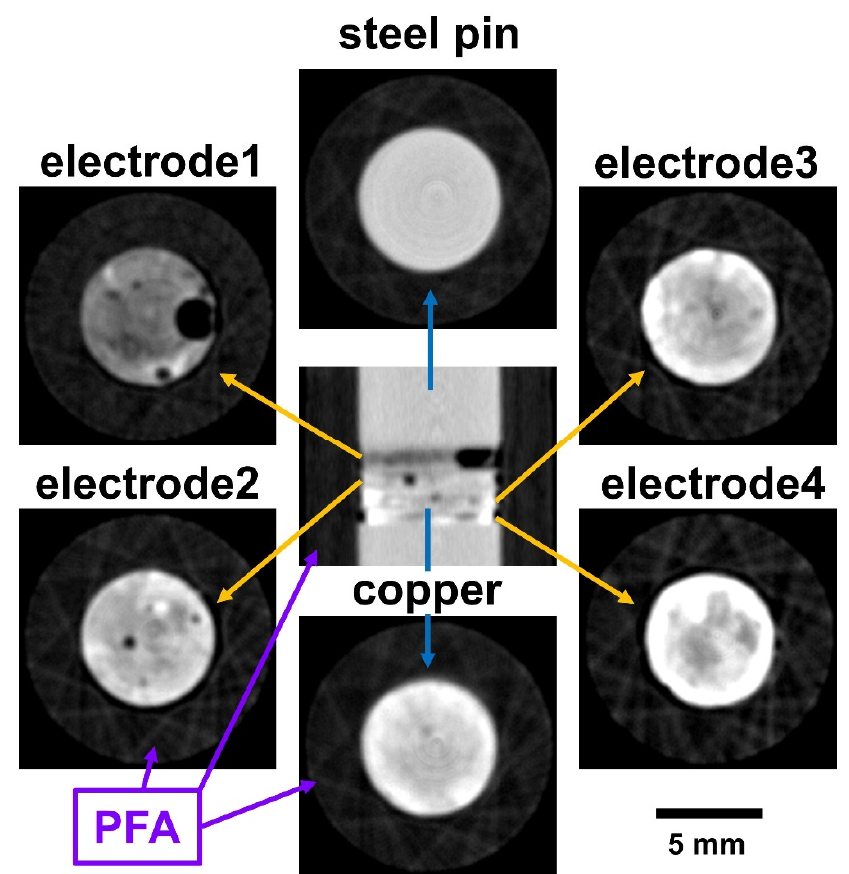
Figure 4. Polychromatic neutron tomographs of the 1 / 4” Swagelok cell: the central image shows a vertical orthogonal slice through the cell. Horizontal slices of the di ff erent cell components are shown including the steel pins, the Cu spacers between the four di ff erent lithiated 6 mm diameter DIT graphite electrodes and the surrounding PFA casing. Due to the modest spatial resolution and the small number of projections, artificial contrast variations and other artefacts may arise.